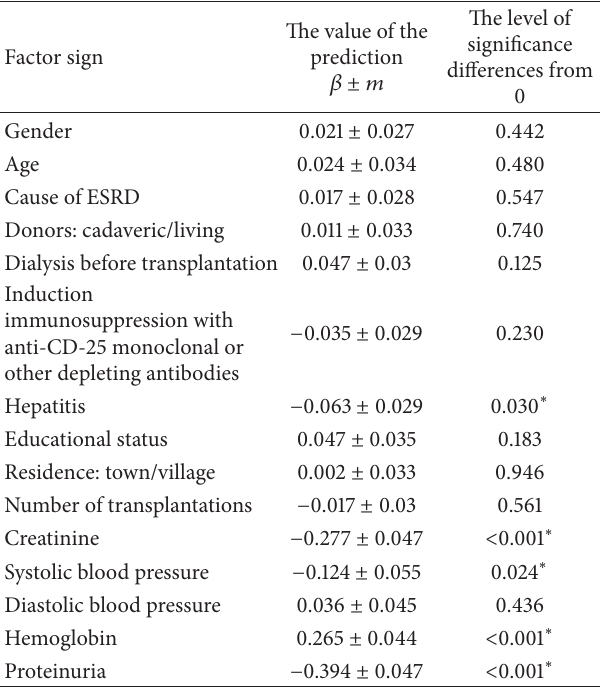
Table 2: Predictive value of basic clinical laboratory and sociode- mographic variables of the survey one year after transplantation.